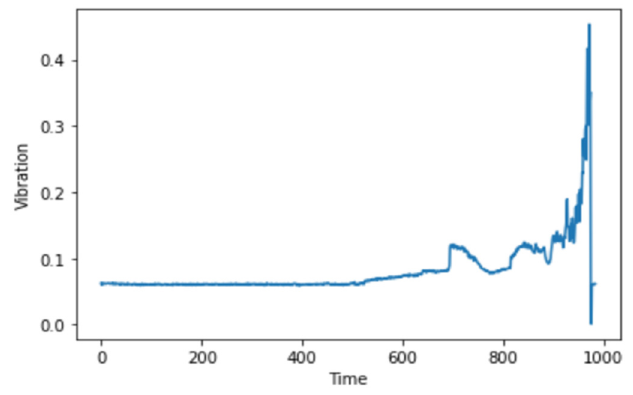
Figure 10. Vibrational signal of Bearing 1 through the entire experiment.